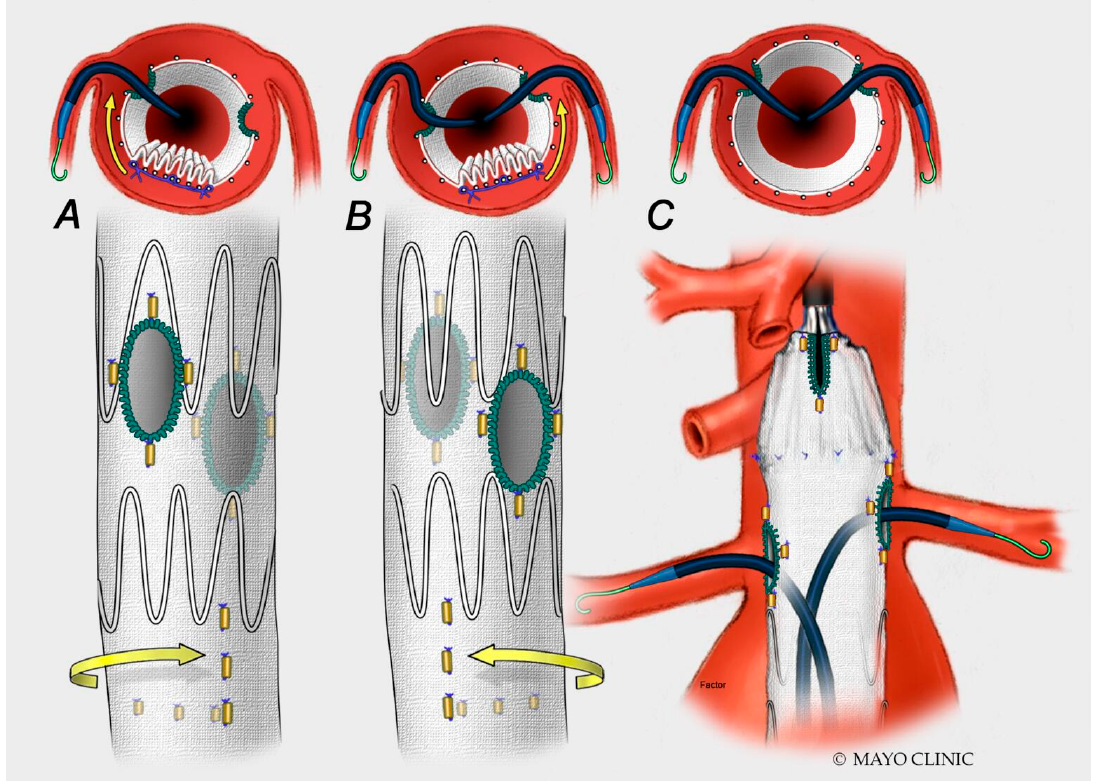
Figure 6. The presence of constraining wires on the back of the endograft allows for some degrees of rotation of the endograft (when partially deployed) in order to facilitate cannulation of the target vessels until the position is stabilized with the use of long introducers and the endograft may be completely deployed. ( A ) Counterclockwise and ( B ) clockwise rotation of the stent-graft to facilitate catheterization of target vessels; ( C ) sheaths inplace in the renal arteries before releasing the diameter- constraining wires on the